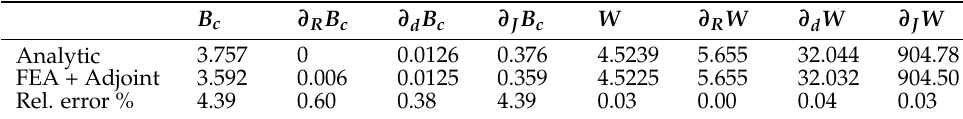
Table 2. Comparison of analytic and adjoint variable